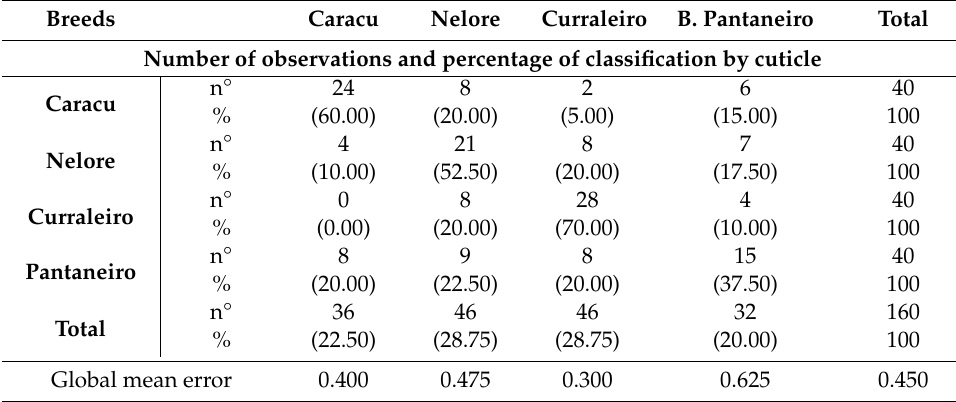
Table 3. Discriminant analysis with number of observations and percentage of guard hair classification of cattle Bovino Pantaneiro, Curraleiro P é -Duro, Caracu and Nelore. Breeds Number of observations and percentage of classification by